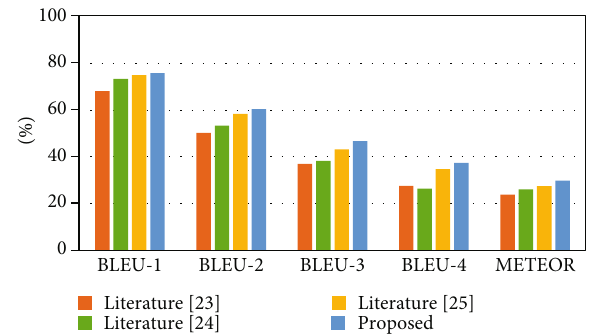
Figure 6: Comparison of experimental results of di ff erent models on the Microsoft COCO dataset.